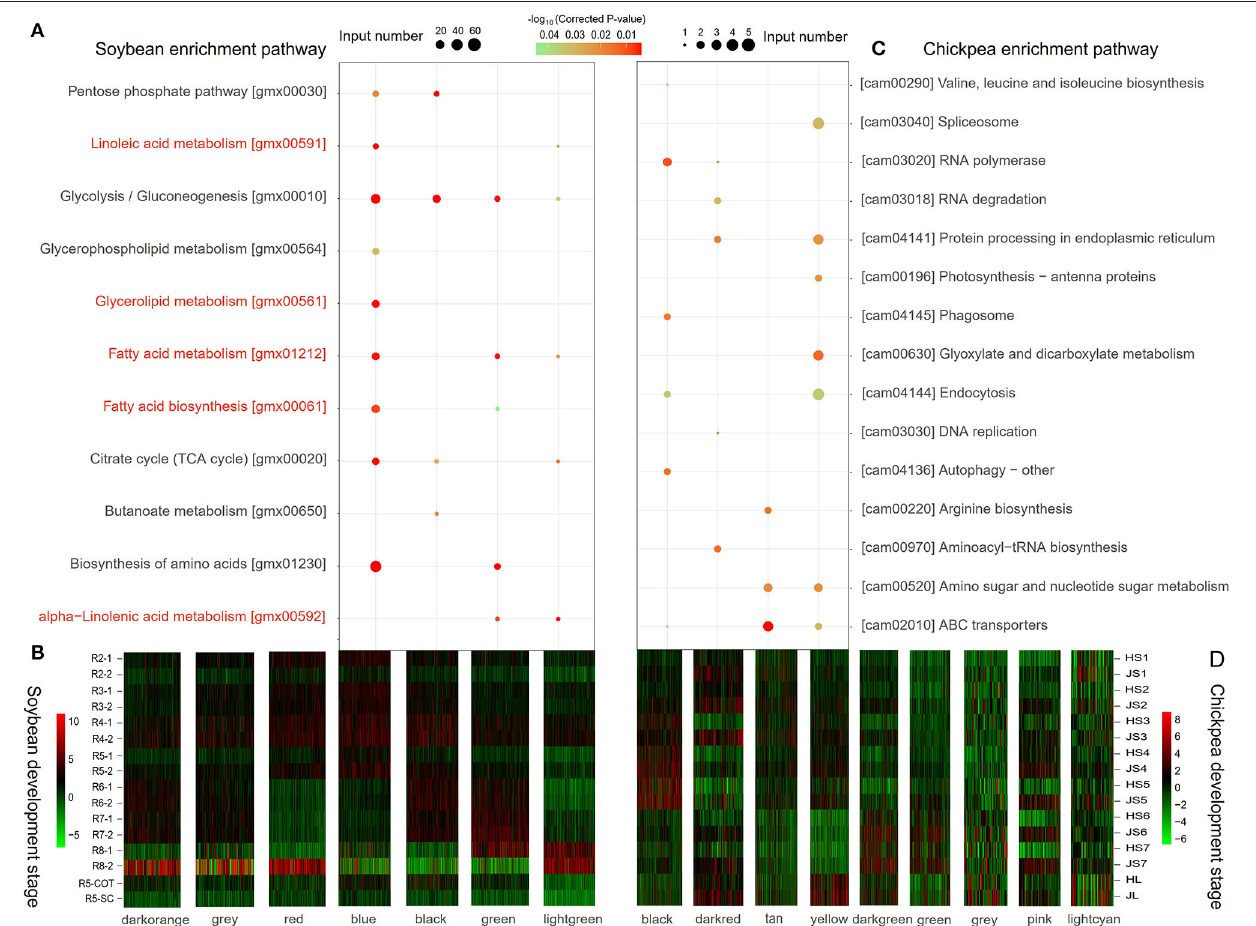
FIGURE 1 | The KEGG pathway enrichment analysis (A,C) and expression heatmap (B,D) of soybean- (A,B) and chickpea-specific (C,D) genes. Among seven modules in soybean-specific genes, all the genes in blue, black, green, and light green modules were significantly enriched in oil synthesis-related pathways. The pathways marked with red color were related to lipid metabolism. Among nine modules in chickpea-specific genes, all the genes in black, dark red, tan, and yellow modules were significantly enriched in cell replication-related